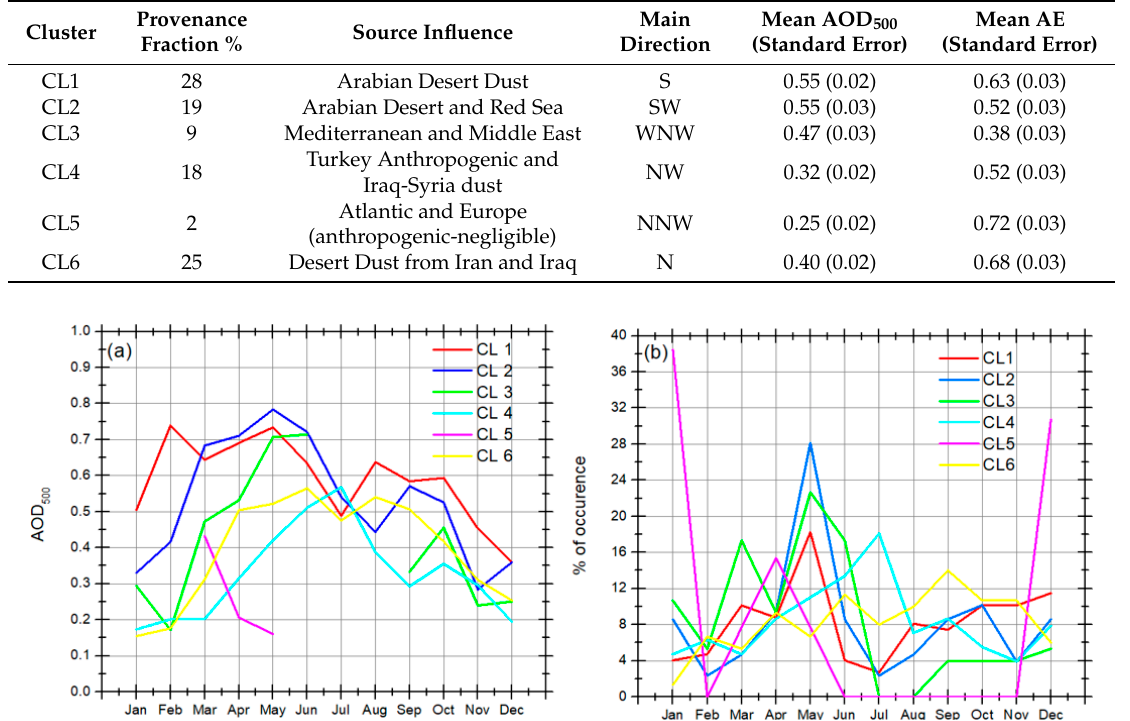
Figure 10. ( a ) Monthly mean values of AOD 500 and ( b ) frequency of occurrence, per trajectory cluster.